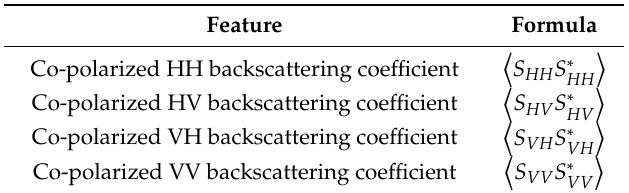
Table 1. Backscattering